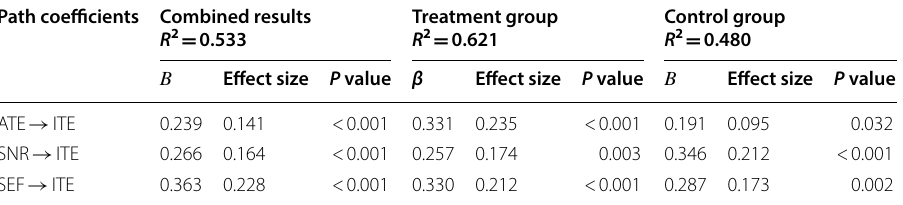
Table 4 Path coefficient comparison Path coefficients Combined results R